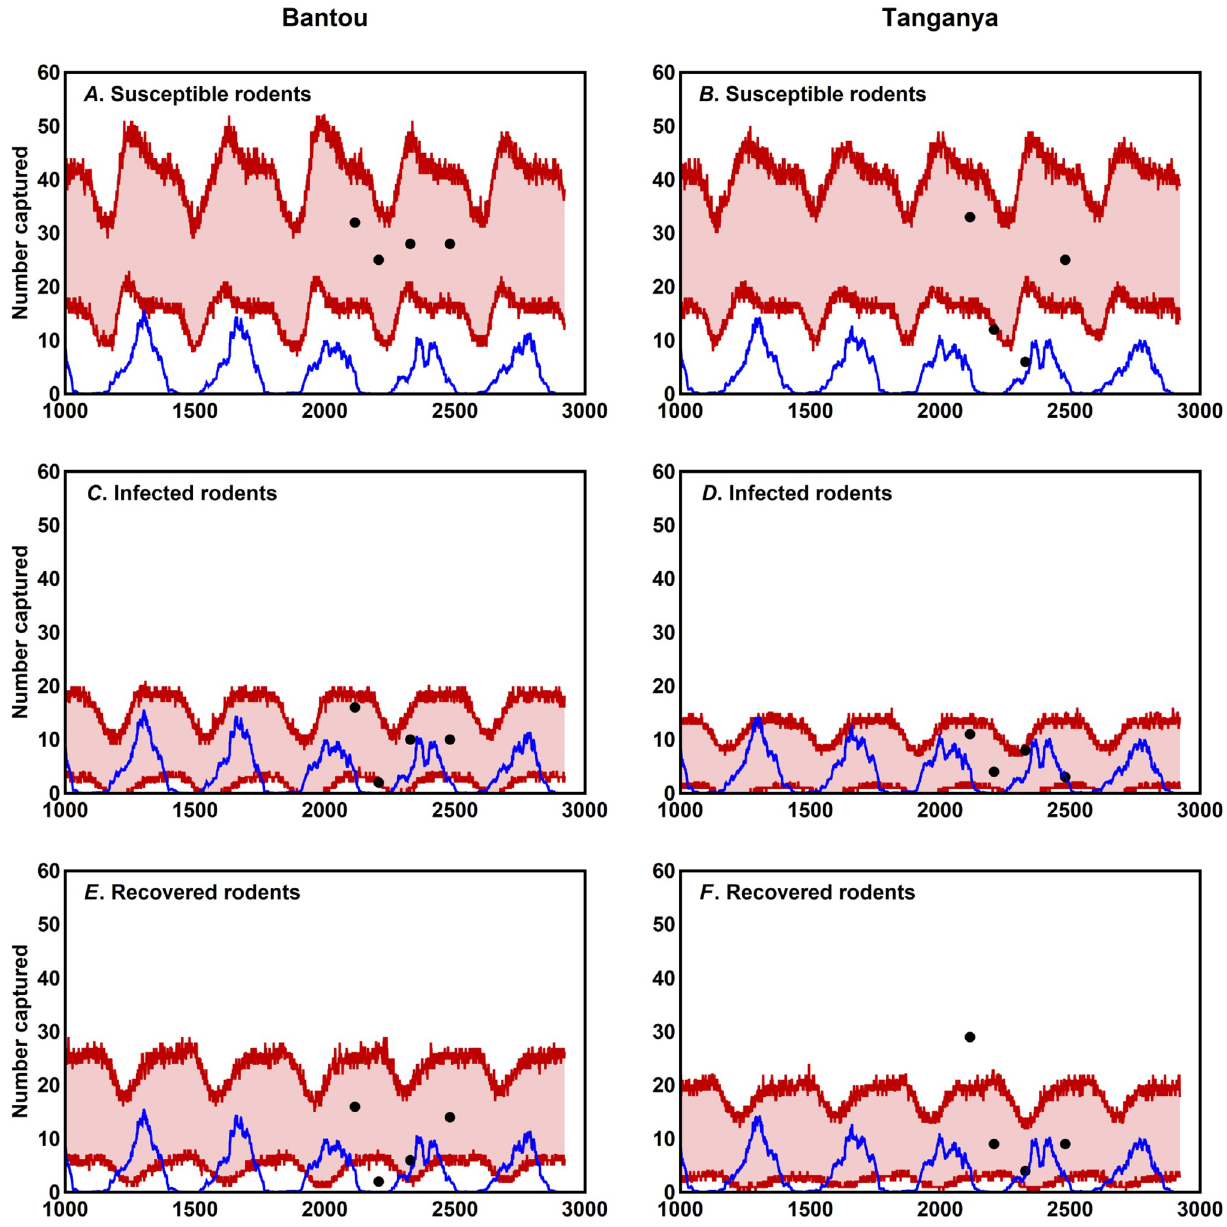
Fig 5. The predicted population and epidemiological dynamics of M . natalensis and Lassa virus within the villages of Bantou and Tanganya over a period spanning the original field study. The first row shows the prediction interval (pink area between red lines) for the number of captured rodents in the S class with black dots indicating capture data from the original study and the blue line average rainfall over the preceding thirty days. The second row shows the same quantities but for rodents in the I class, and the third row for rodents in the R class. Prediction intervals were generated by: 1) drawing parameter vectors at random from the posterior distribution, 2) Simulating dynamics forward in time using precipitation data for each village from the CHIRPS 2.0 database, 3) Conducting daily simulated rodent trapping experiments, 4) repeating this procedure for 200 random draws from the posterior distribution, and 5) calculating 95% prediction interval for each day by eliminating the upper and lower 2.5% of simulated